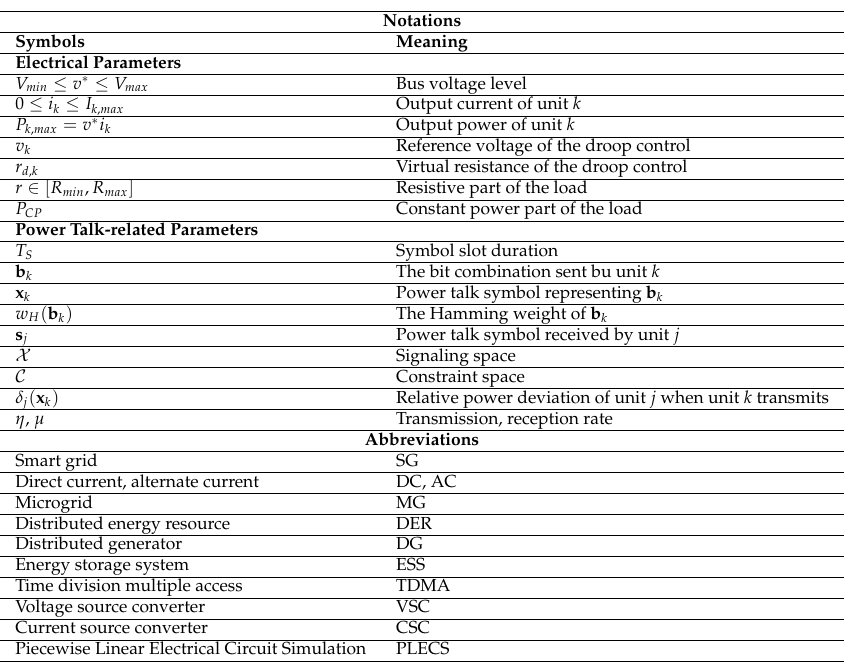
Table 1. List of symbols and